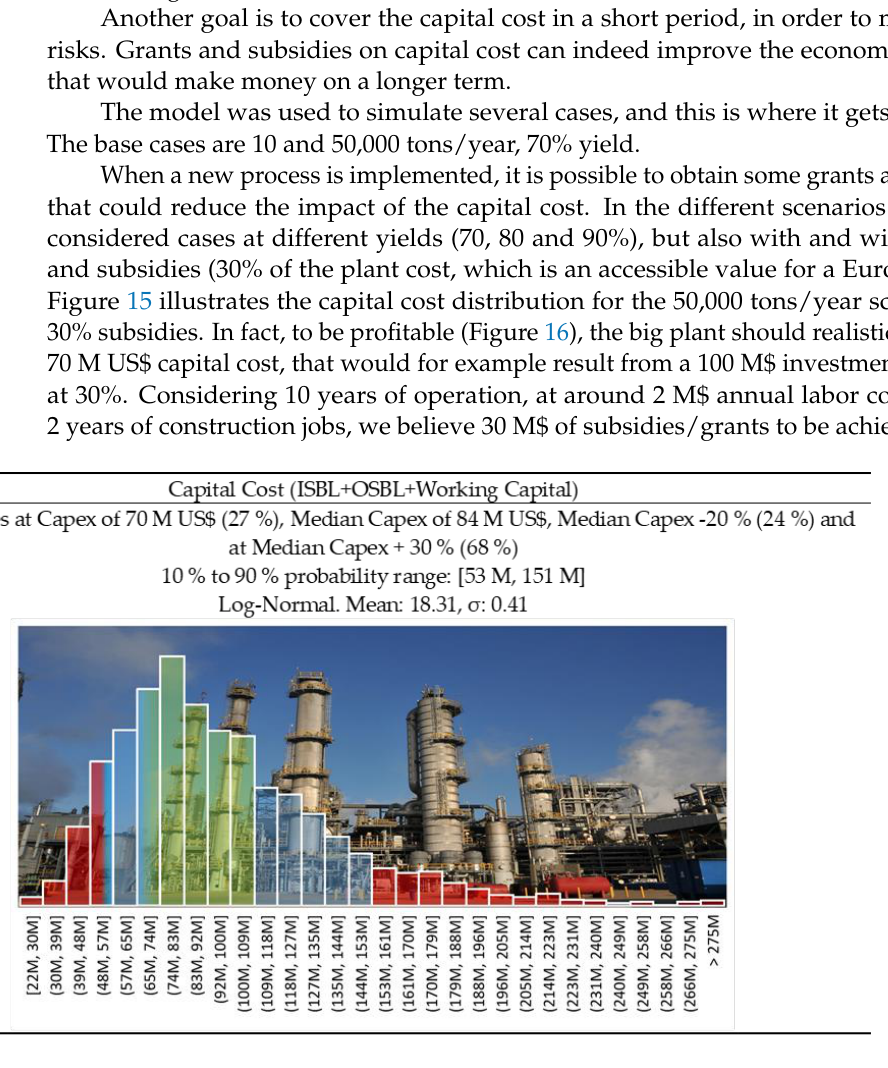
Figure 15. Capital cost distribution for a big plant (50 ktons/year) and taking into account 30% subsidies—CAPEX −20%/+ 30% (green area) corresponds to Class 3 confidence interval of the Association for the Advancement of Cost Engineering (AACE) [73].